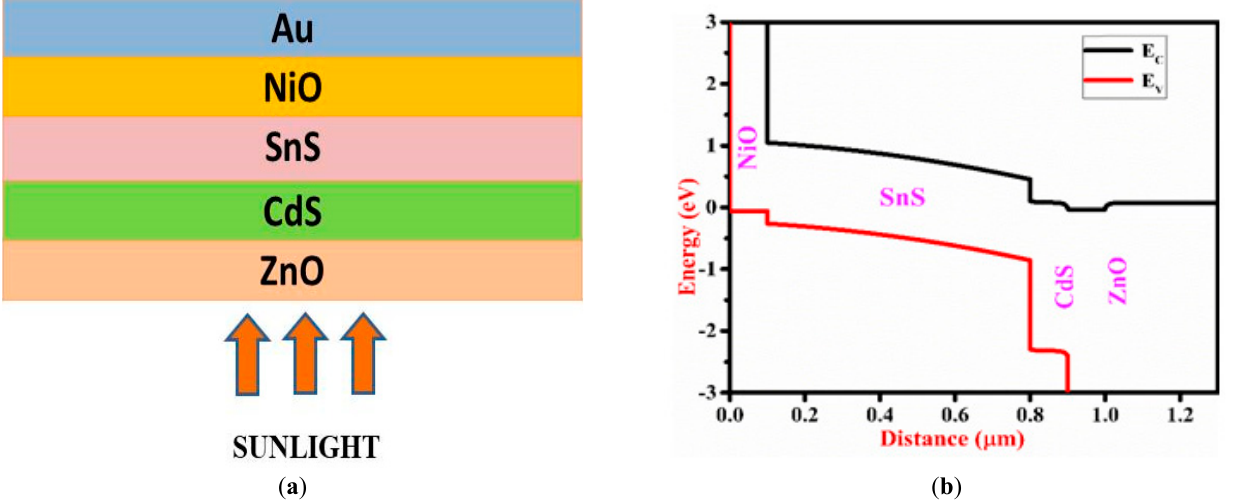
Figure 1. ( a ) Schematic structure and ( b ) energy band diagram of the proposed solar cell. Table 1. Parameters of ZnO [26], CdS [27], SnS [28] and NiO [14] used in the simulation of proposed solar cell.